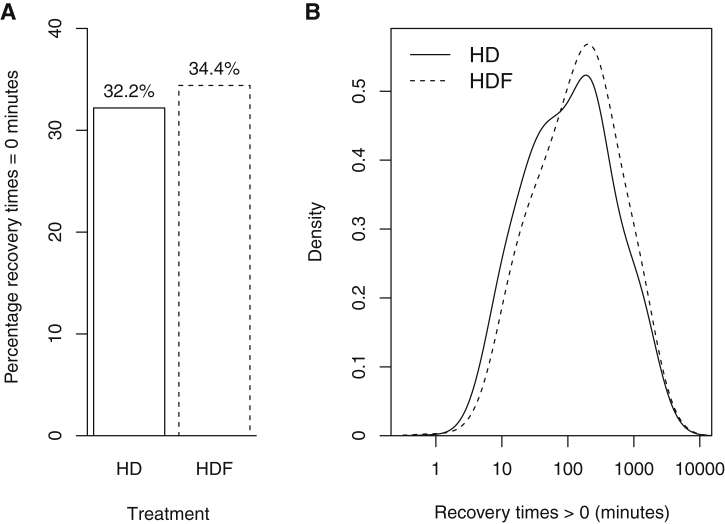
Bar and density plots of immediate and delayed recovery times for high-flux hemodialysis (HD) and hemodiafiltration (HDF). (A) Bar plot shows percentage of recovery times that were recorded as equal to zero minutes. (B) Density plot shows delayed (>0 minute) recovery times for HD and HDF. X-axis presented on log 10 scale.